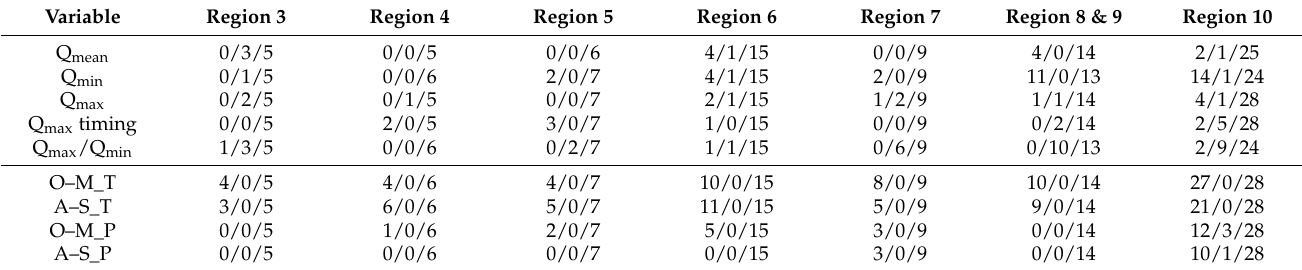
Seven regions are defined according to the Water Survey of Canada drainage regions, which include: (3) Labrador, Northwestern Quebec; (4) Albany; (5) Nelson; (6) Arctic, Hudson Bay; (7) Upper Mackenzie; (8) and (9) Pacific and Yukon; and (10) Arctic, Lower Mackenzie and